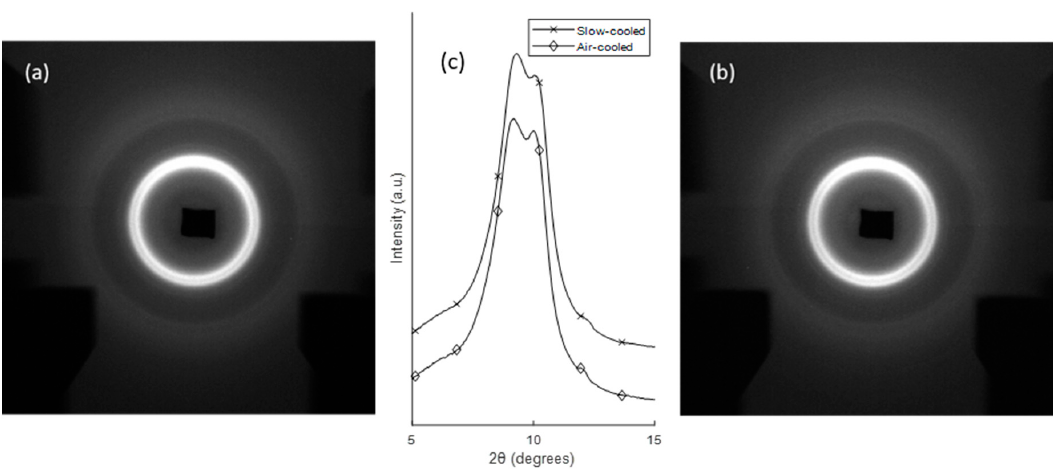
Figure 8. Two-dimensional and 1D WAXS patterns of the Nylon-12 samples. ( a ) Filament pattern, with only the 001( + 201) peak visible. ( b ) FFF RS sample, with the shoulder corresponding to the 200 peak. ( c ) FFF Apium sample with two peaks clearly visible. ( d ) shows the 1D line profiles plotted as a function of di ff raction angle 2 θ . The dark shadow in ( b ) is due to partial beam blockage from a modified sample holder.